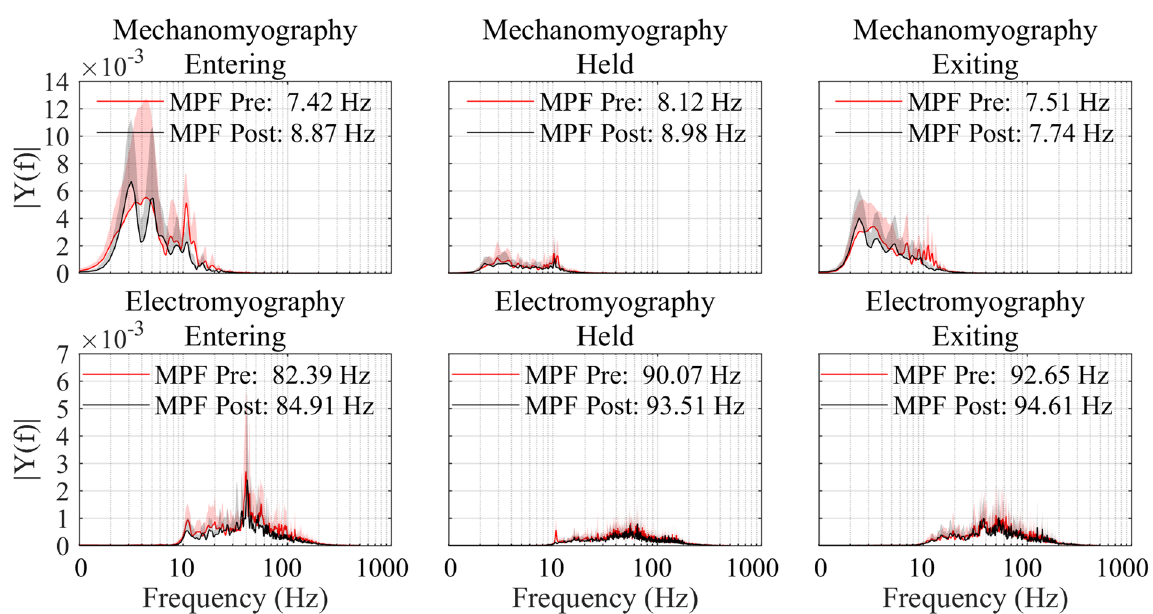
Figure 2. Grouped participant data showing comparison of pre (red) and post-exertion (black) MPF results for MMG (top row) and EMG (bottom row). Data have been divided into entering the squat (left column), holding the squat (middle column), and exiting the squat (right column). Standard deviation is plotted as a shaded